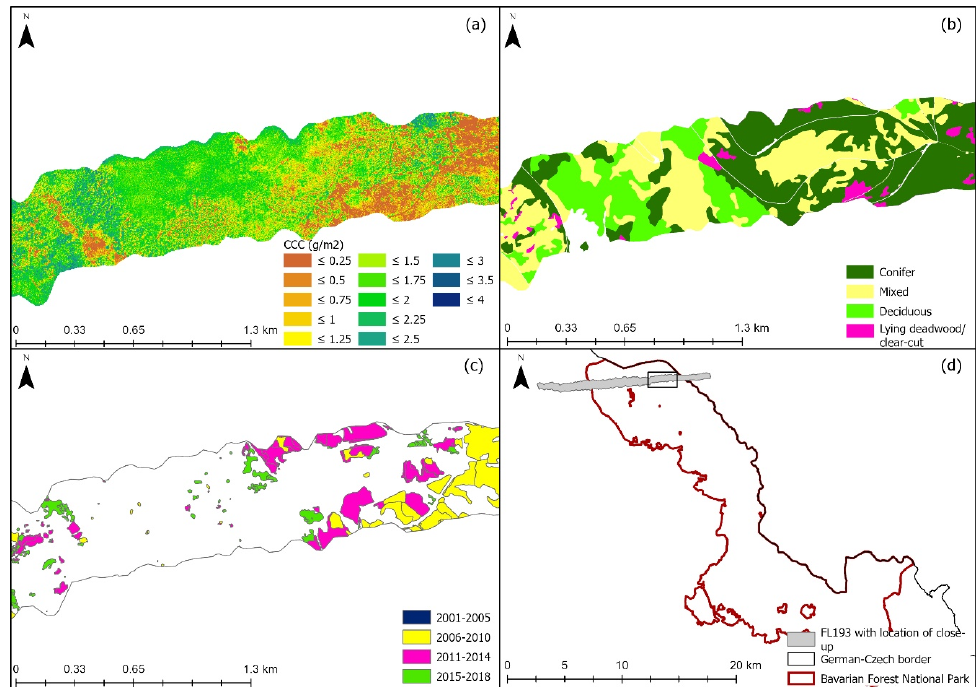
Figure 6. Close up of eastern site of light line 193; ( a ) Canopy chlorophyll content map derived with PLSR, ( b ) Land cover classification map, ( c ) Deadwood classification map, ( d ) Location plan of flight line 193 and the close-up in relation to the Bavarian Forest National Park. Forest classification map from land cover map. Deadwood classification map from infestation map (obtained from aerial photographs) available from the national park administration [85].